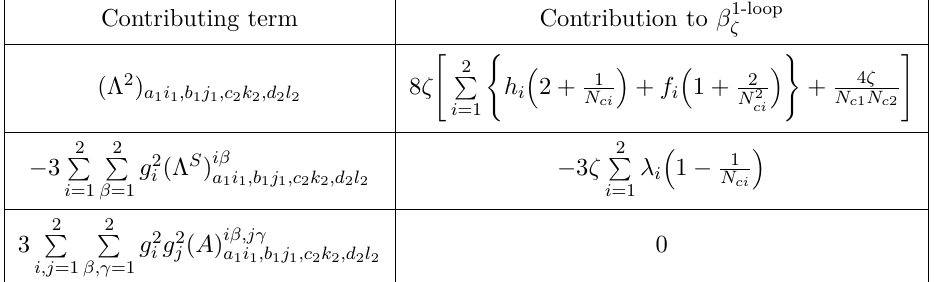
Table 2. Contribution of different terms to β 1-loop